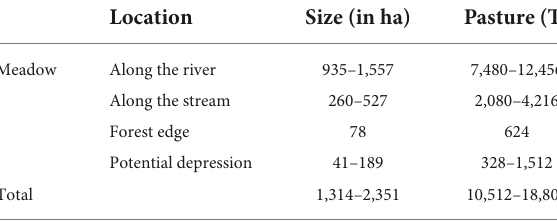
TABLE 5 The estimation of the Meadow zones in a 5 km radius survey area around the Bronze Age Stepnoye settlement in 2017. Location Size (in ha) Pasture (T) Meadow Along the